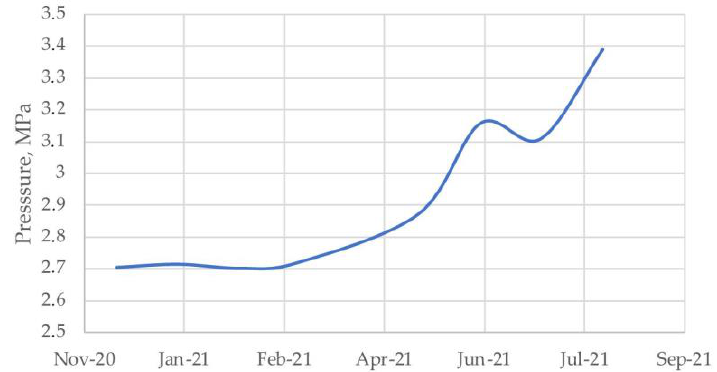
Figure 2. Change in intercasing space pressure.